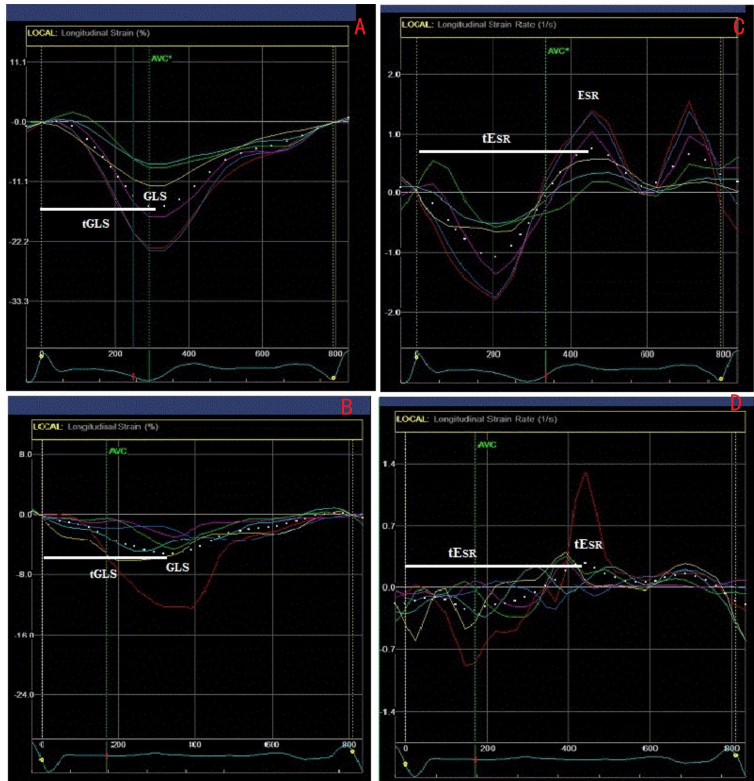
Figure 2. Left ventricular (LV) myocardial strain ( A , B ) and strain rate ( C , D ) curves in a healthy participant ( A , C ) and in a LQTS ( B , D ) patient. In the LQTS patient there is LV dyssynchrony and prolonged duration of global LV (white dotted curve) myocardial shortening (tGLS) with peak LV global longitudinal strain (GLS) occurring after the aortic valve closure (AVC); also peak global early diastolic strain rate (tESR) occurs